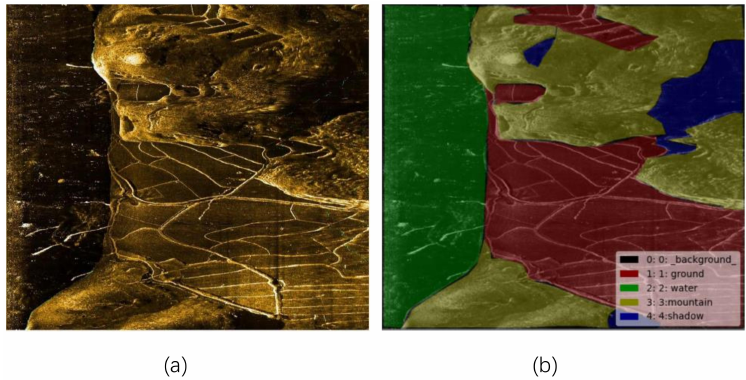
Figure 6. ( a ) Original image, ( b )